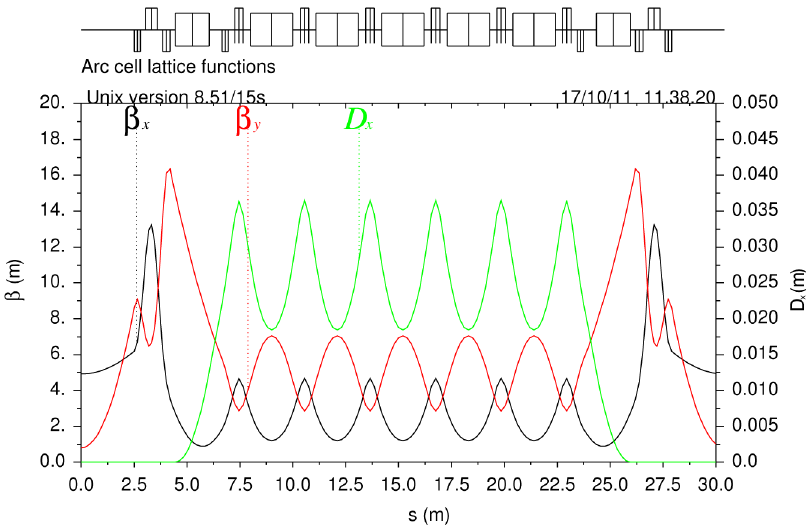
FIG. 6. Lattice functions in PEP-X MBA cell with 7 dipoles. Four quadrupoles on each side of the ID straight can be used for variation of ID beta